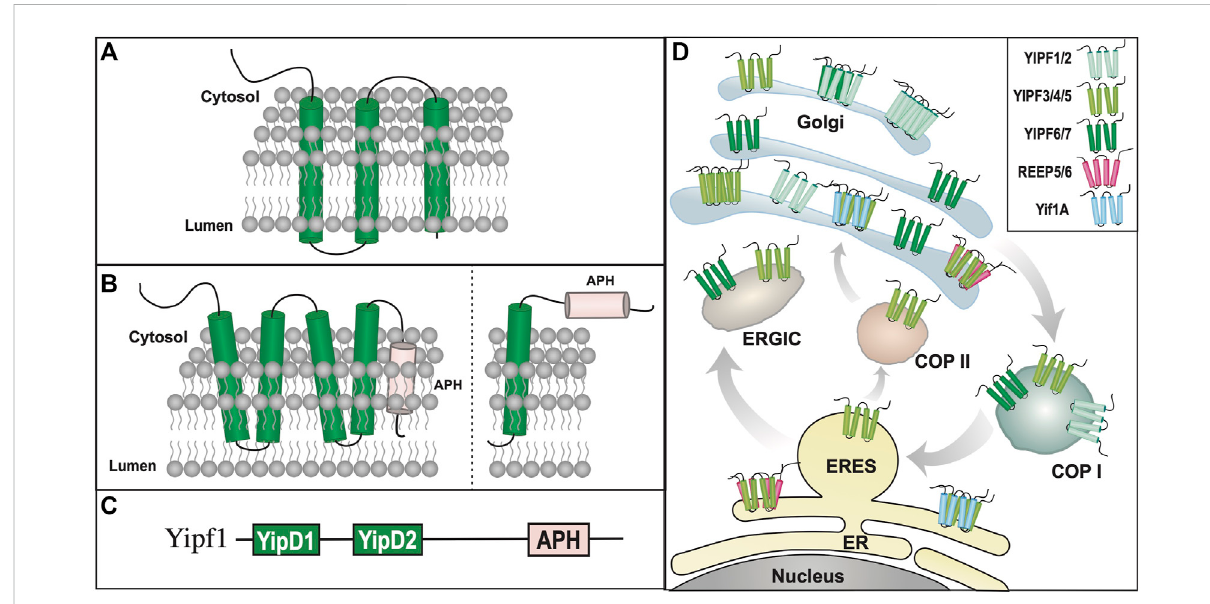
FIGURE 2 Yipf/Yip1p Family of Proteins. (A). When originally discovered, Yip1p was modeled as a three transmembrane domain containing protein (Yang et al., 1998). (B). Left: Alternative transmembrane topology model of Yip4p and Yip5p based on further biochemical analyses (Calero et al., 2002). Note that the membrane localization of the carboxy terminus of Yip4p/5p was determined to be intraluminal. Right: An alternative model predicted by AlphaFold (Jumper et al., 2021; Varadi et al., 2022), and yeast Yip4p/5p data (Calero et al., 2002), suggesting that their carboxy termini are closelyalignedwithintheER/Golgimembrane,possiblyasanAPHthatiseitheralignedorburiedwithinthemembrane. (C). Yipfamilymembershave twoconservedYip1Domains( YIPD )thatmayinsertintothemembraneasdualhairpinstructures,whicharenecessaryforYipfamilyhomomericand heteromeric interactions. Additionally, all members possess a carboxy terminal amphipathic helical domain ( APH ). (D). Intracellular localization of various Yipf family members is shown within the ER, Golgi, and ERGIC compartments, including intracellular transport vesicles, COPI and COPII. Modeled proteins are not shown to scale relative to their amino acid sequence. ER = Endoplasmic Reticulum, ERES = ER Exit Site, ERGIC = ER/Golgi Intermediate